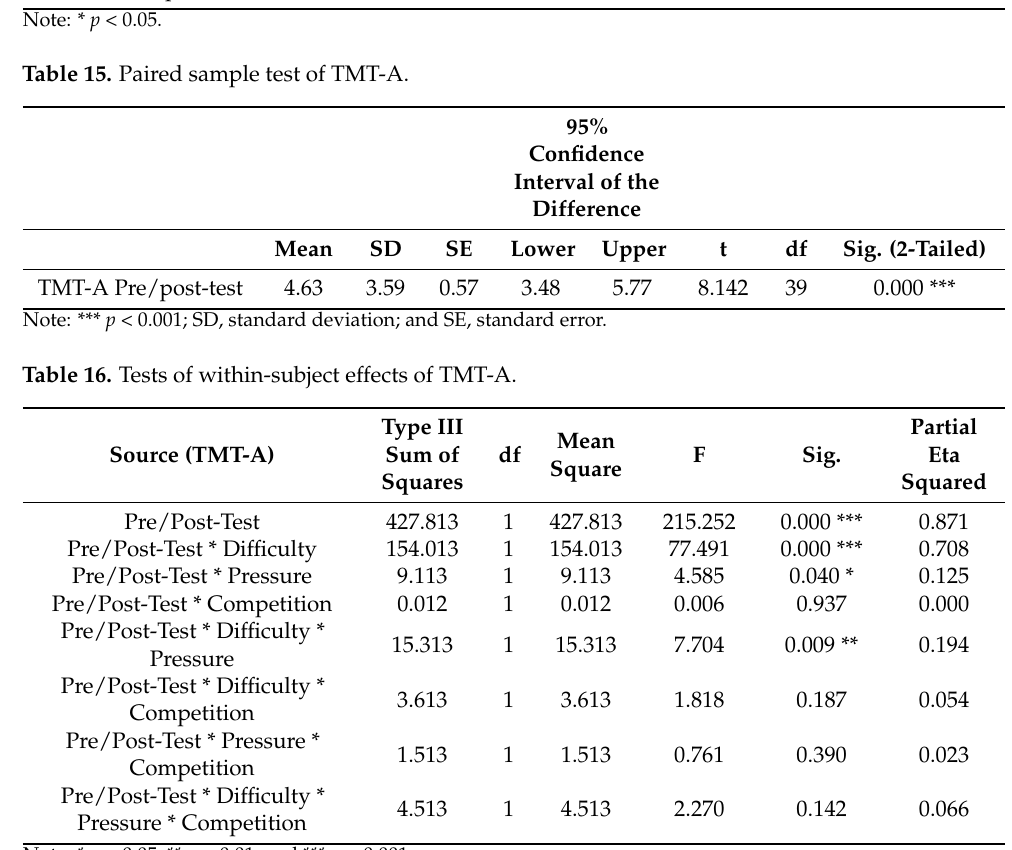
Table 17. Estimated marginal means of TMT-A—Interaction of difficulty * pressure * pre/post-test.